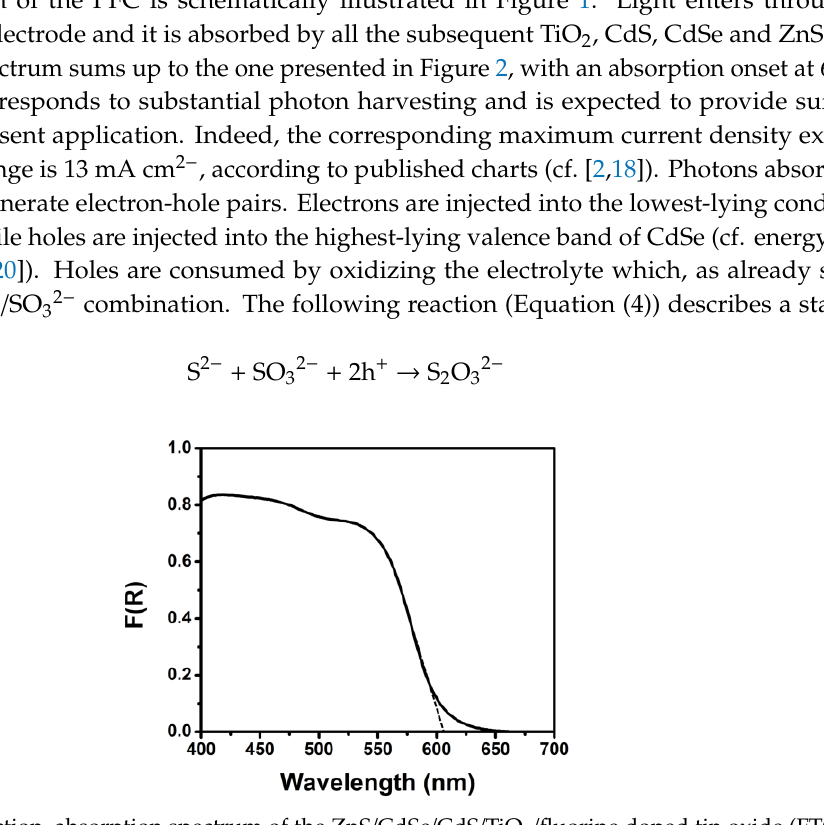
Figure 2. Reflection–absorption spectrum of the ZnS / CdSe / CdS / TiO 2 / fluorine doped tin oxide (FTO) photoanode electrode.